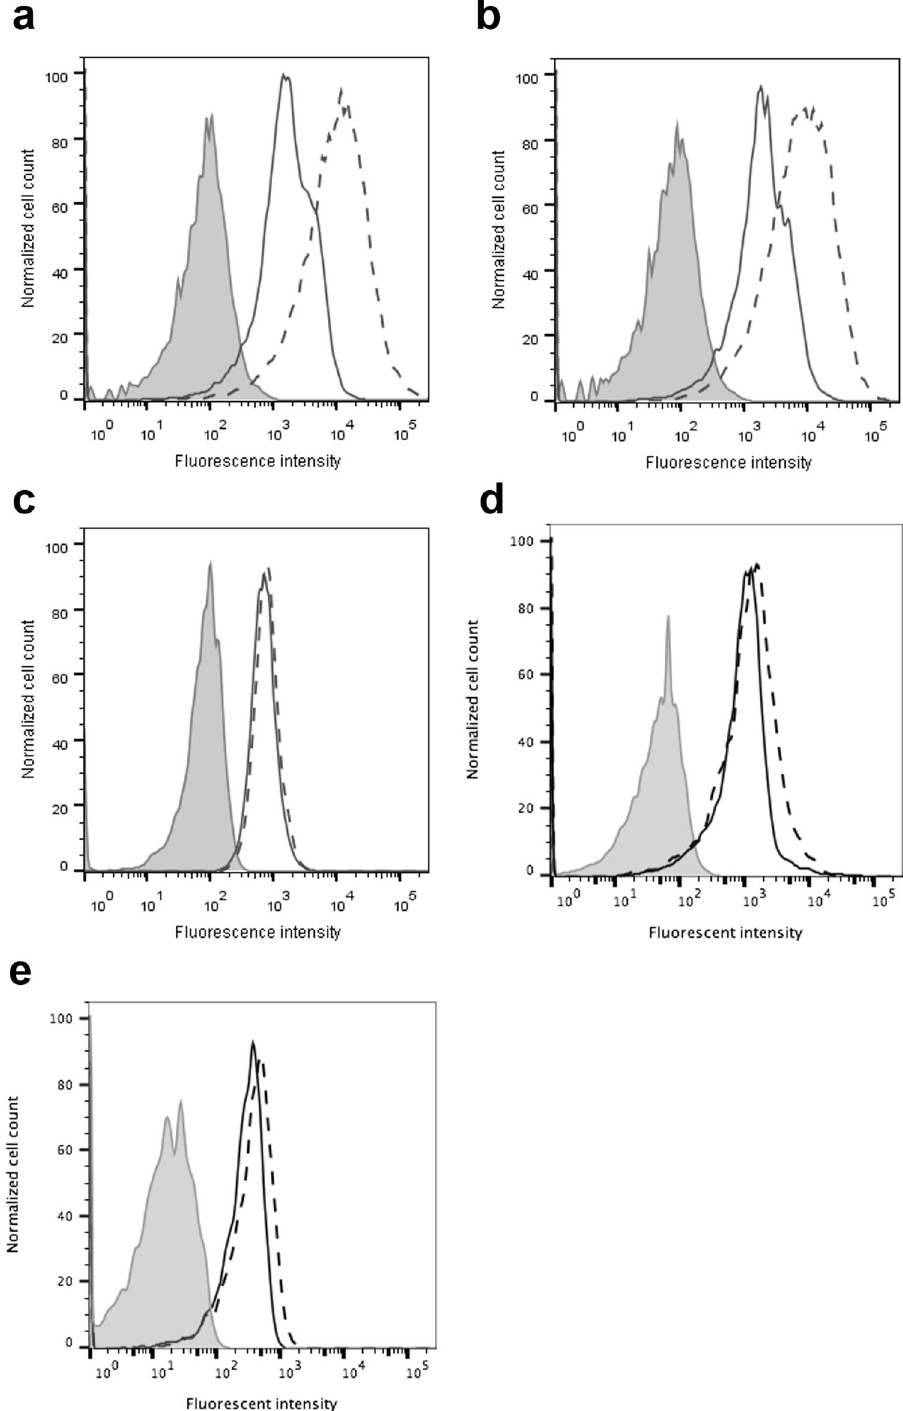
Figure 4. Effect of heparin on hIL-12 binding to cell surfaces. ( a ) NK-92MI cells, ( b ) IL-12R β 1 mut /IL-12R β 2 mut NK-92MI cells, ( d ) HEK-293 cells or ( e ) PBMCs cultured with AF647-IL12 alone (solid line) or AF647-IL12 plus 10 μ g/ml heparin (dashed line). Untreated cells (filled histogram) served as a negative control. ( c ) NK-92MI cells (solid line) and IL-12R β 1 mut /IL-12R β 2 mut NK-92MI cells (dashed line) were cultured for 1 hour at 4 °C with heparin-Cy5. Untreated NK-92MI cells (filled histogram) served as a negative control. Each panel shows the relative amounts of AF647-IL12 or heparin-Cy5 binding to cells as assessed via flow